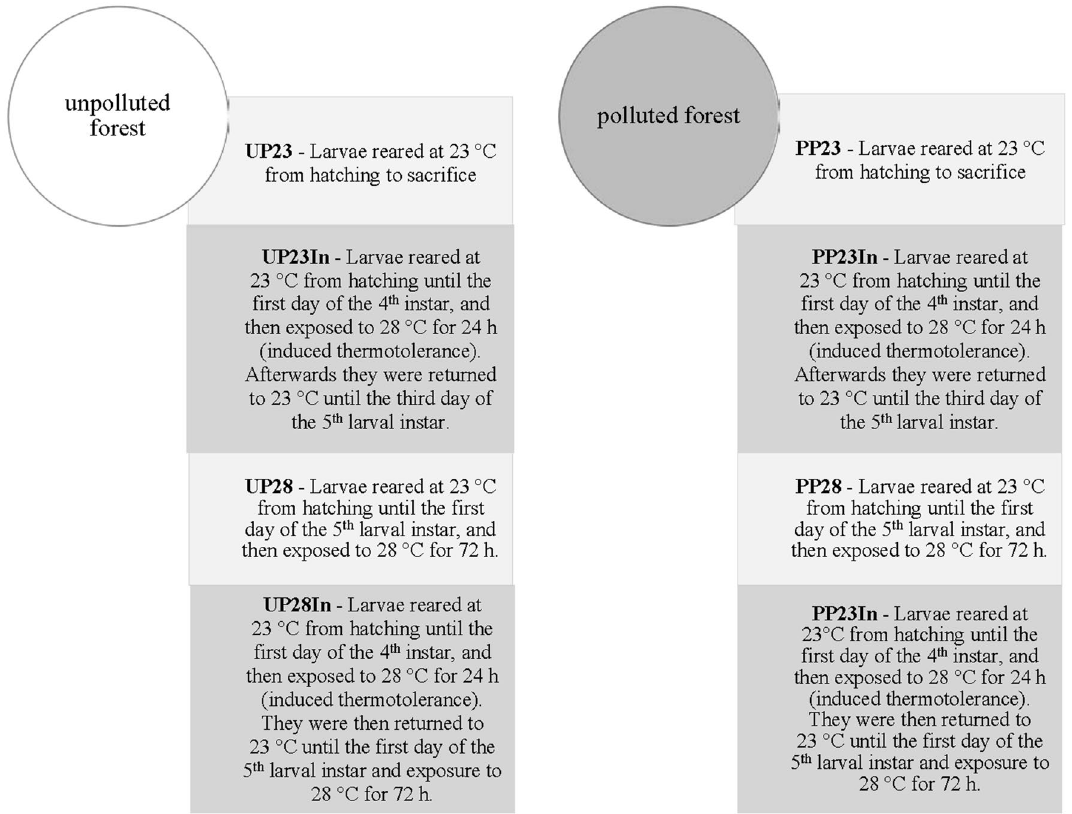
Figure 7. A schematic figure of the experimental